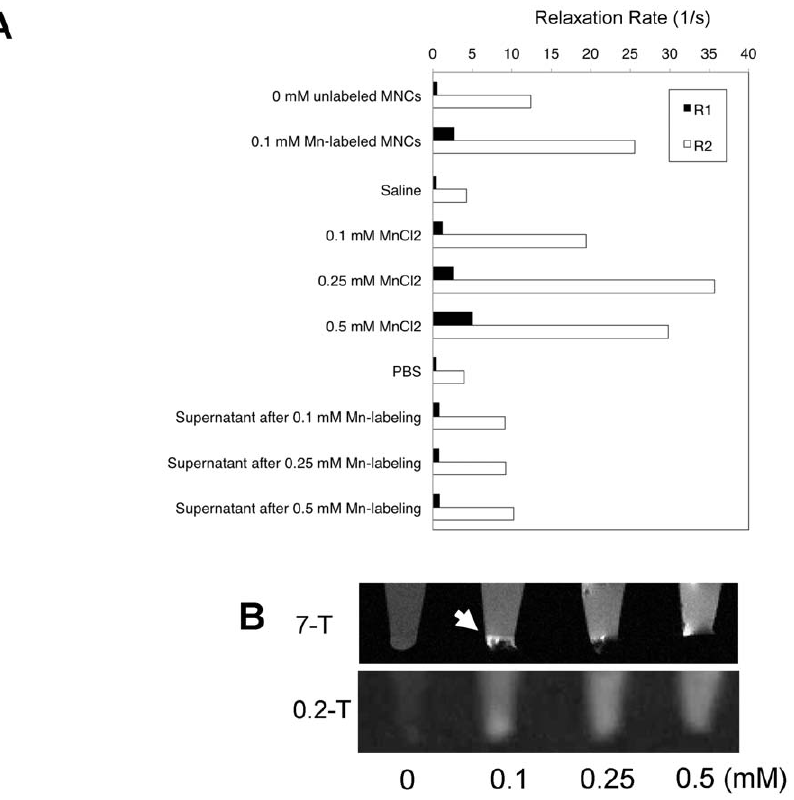
Figure 1. Relaxation times and contrast of Mn-labeled MNCs. (A) R 1 and R 2 calculated for the in vitro samples are presented. The pelleted 0.1 mM Mn-labeled MNCs showed larger R 1 and R 2 in comparison to the saline control. It was not possible to calculate the R 1 and R 2 values for the MNCs with 0.25 mM Mn-labeling and over (N/A) because the T 2 was too short due to the large susceptibility effect. The R 1 s of the MnCl 2 solutions were approximately linearly correlated with the Mn concentration. The R 1 and R 2 for the supernatant fluid were approximately independent of the initial Mn labeling concentration. (B) T 1 -weighted sagittal images of pelleted MNCs after suspension in 0, 0.1, 0.25, and 0.5 mM Mn solutions. The pelleted MNCs at 0.1 mM MnCl 2 -labeling showed partial signal enhancement in the T 1 -weighted 7 T MRI (arrow). The pelleted MNCs with MnCl 2 - labeling over 0.25 mM lost signal in comparison with the unlabeled (0 mM) control due to the very short T 2 and the T 2 * susceptibility effect at 7 T. In the 0.2 T MRI, the the 0.1, 0.25 and 0.5 mM MnCl 2 -labeled MNCs showed positive contrast, although there may have been some signal loss at the base of the 0.5 mM sample.